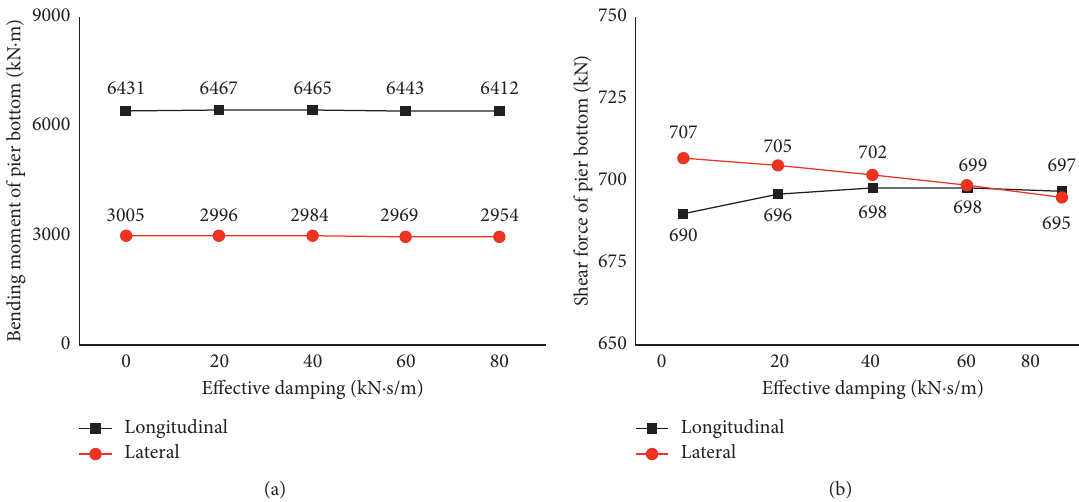
Figure 8: Seismic response of pier in different directions with the variation of effective damping: (a) bending moment of pier bottom; (b) shear force of pier